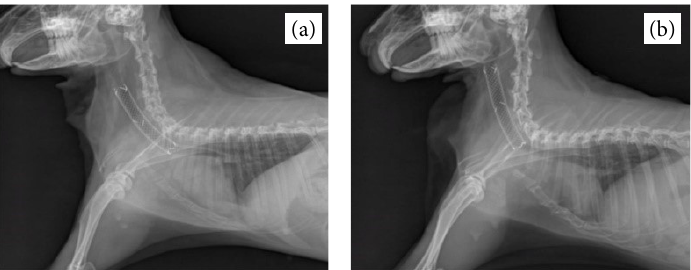
Figure 7 - Lateral radiographic views of the trachea in a rabbit model before and after stent migration. (a) An S-type stent with a wire diameter of 0.006 inches was placed in the trachea of a rabbit. (b) Proximal stent migration resulting in respiratory